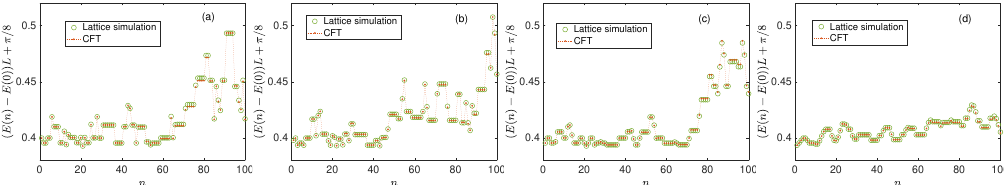
Figure 20: Comparison of lattice simulations and CFT results for the total energy evolution in the heating phase with a single random sequence. Here we choose the same random sequence and driving parameters as Fig.